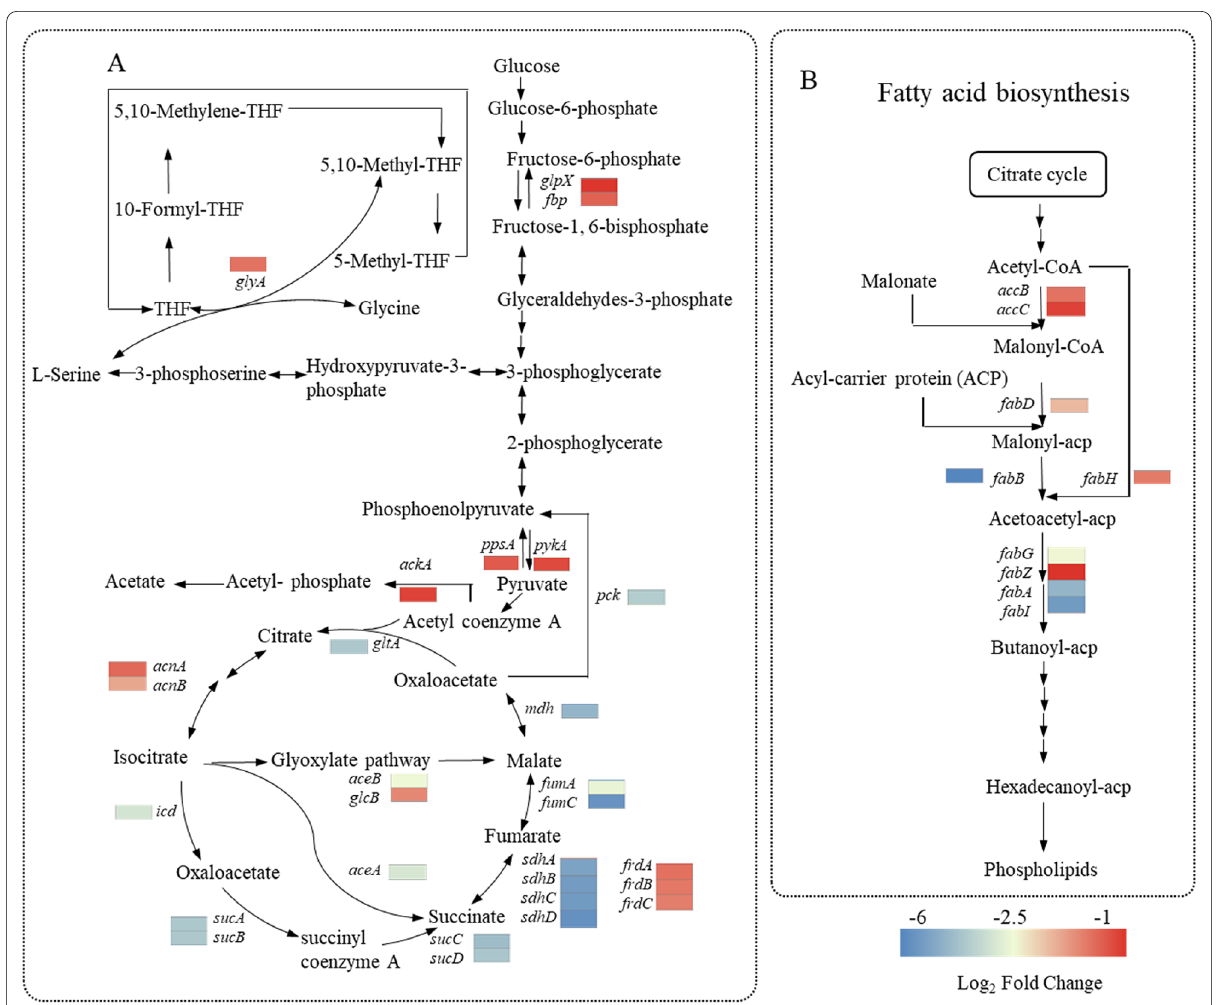
Fig. 7 Expression profiles of selected genes of E. coli W3110 cells under gallic acid stress versus fermentation without stress. Genes related to carbon metabolism ( A ) and fatty acid biosynthesis ( B